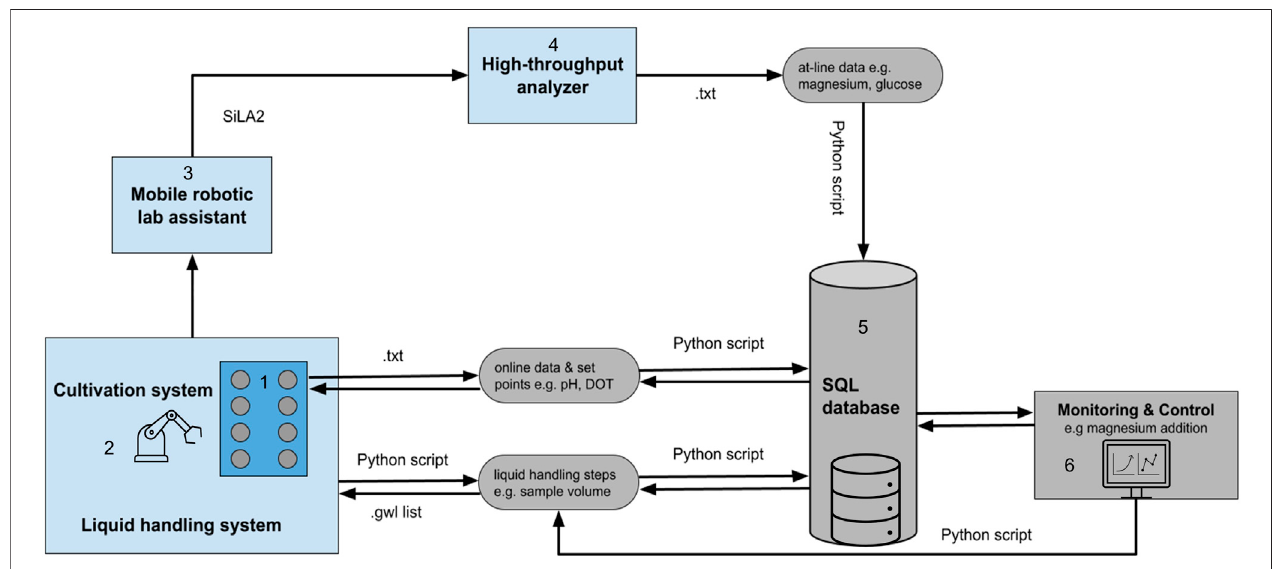
FIGURE 2 | Schematic representation of the device (light blue) and data integration (light grey) in the facility. The facility is composed of a 1) cultivation system, 2) liquidhandlingstation, 3)mobileroboticlabassistant,4)high-throughputanalyzer,5)SQLdatabase,anda6)monitoringandcontrolsystem.Allprocessdataarestored in the central database. The communication, data transfer, and control rely on different fi le formats, e.g., txt- and gwl-list. Necessary reading and control dependent writingofthese fi lesareautomaticallyperformed via Pythonscriptsanddatabasequeries.Themobileroboticlabassistantiscontrolled via aSiLA2serverandclient architecture. SQL, Structured Query Language; SiLA, Standard in Laboratory